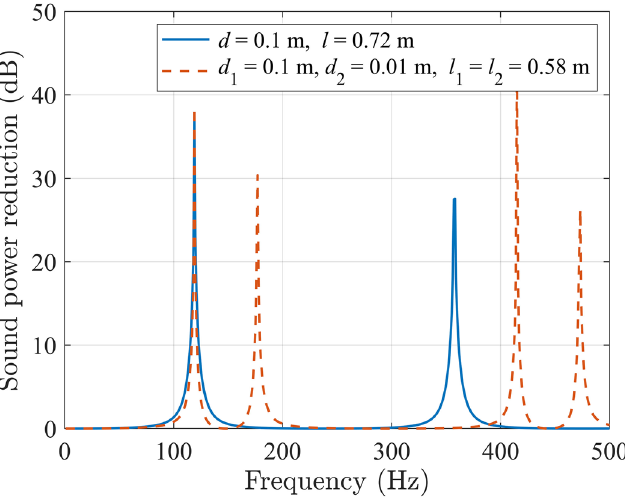
Figure 2. The reduction of the sound power radiated to the downstream in a duct with a side branch tube with a uniform cross section or two coupled tubes with different cross sections.